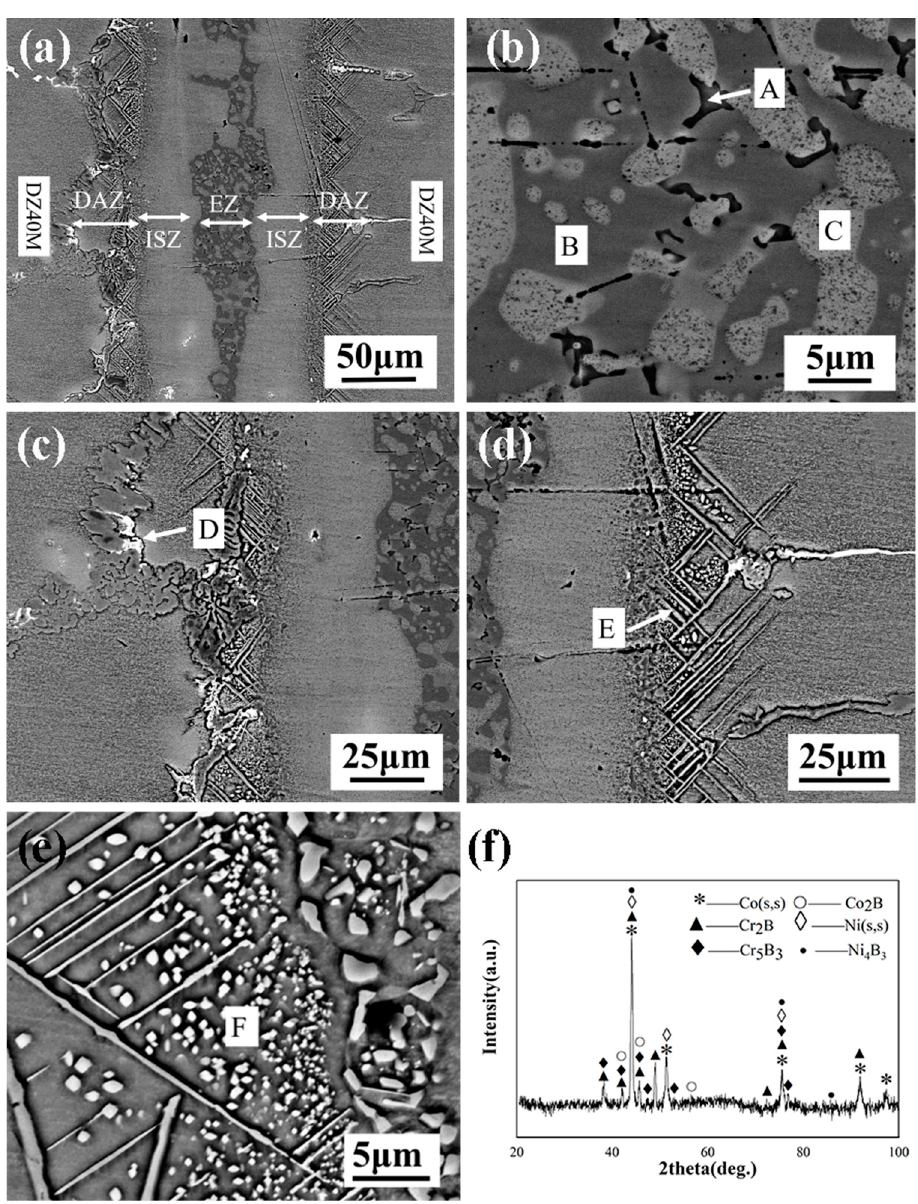
Figure 4. Typical microstructure of TLP-bonded joints of DZ40M at 1120 ° C /30 min: ( a ) integral view; ( b ) EZ; ( c ) the left of DAZ; ( d ) the right of DAZ; ( e ) enlarged view of DAZ and ( f ) XRD pattern of the joint.